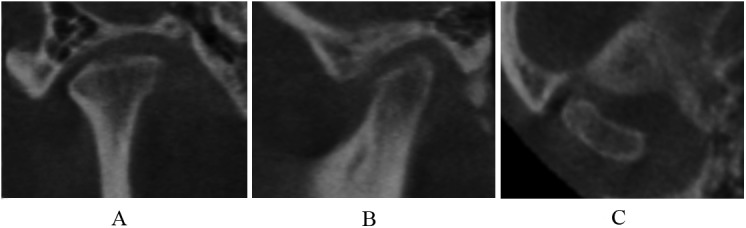
Short condyles in coronal (A), sagittal (B), and axial (C) images.